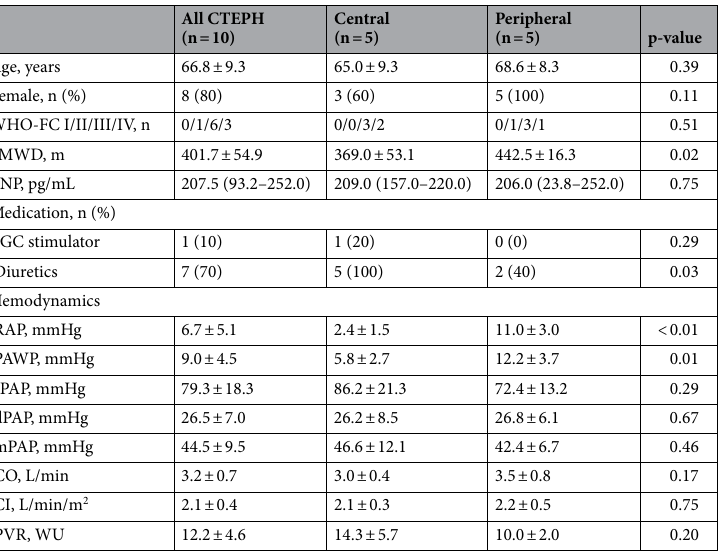
Table 1. Baseline characteristics of the study population. Data are presented as n (%), mean ± SD, or median (interquartile range). WHO-FC, World Health Organization functional class; 6MWD, 6-min walk distance; BNP, brain natriuretic peptide; sGC, soluble guanylate cyclase; RAP, right atrial pressure; PAWP, pulmonary artery wedge pressure; sPAP, systolic pulmonary artery pressure; dPAP, diastolic pulmonary artery pressure; mPAP, mean pulmonary artery pressure; CO, cardiac output; CI, cardiac index; PVR, pulmonary vascular